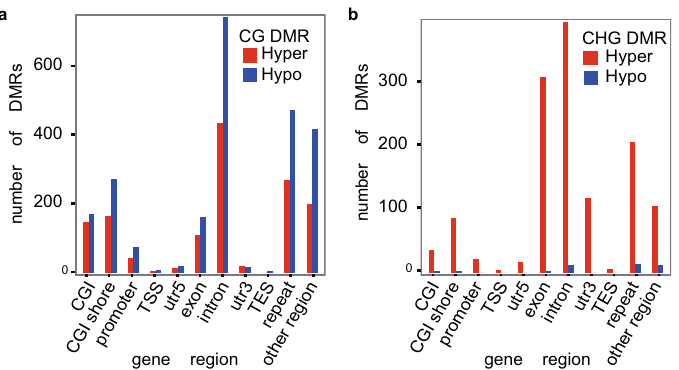
Figure 3. Comparisons of hyper (high) and hypo (low) methylation DMRs against gene regions in CG and CHG methylation contexts in adipose. ( a ) Frequency of hyper CG and hypo CG methylation in CGI, CGI shore, promoter, TSS, utr5, exon, intron, utr3, TES, repeat and other gene regions. ( b ) Frequency of hyper CHG and hypo CHG methylation in CGI, CGI shore, promoter, TSS, utr5, exon, intron, utr3, TES, repeat and other gene regions.